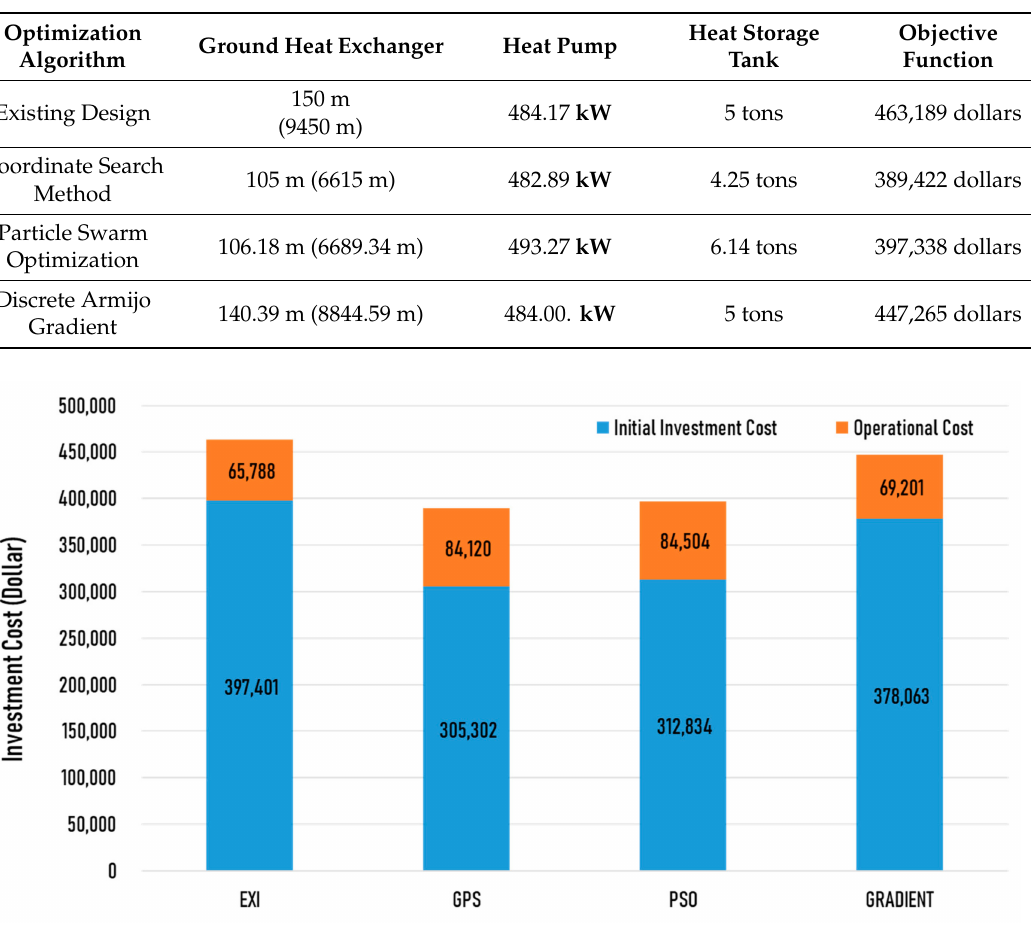
Figure 13. Life-cycle cost of each case for 10